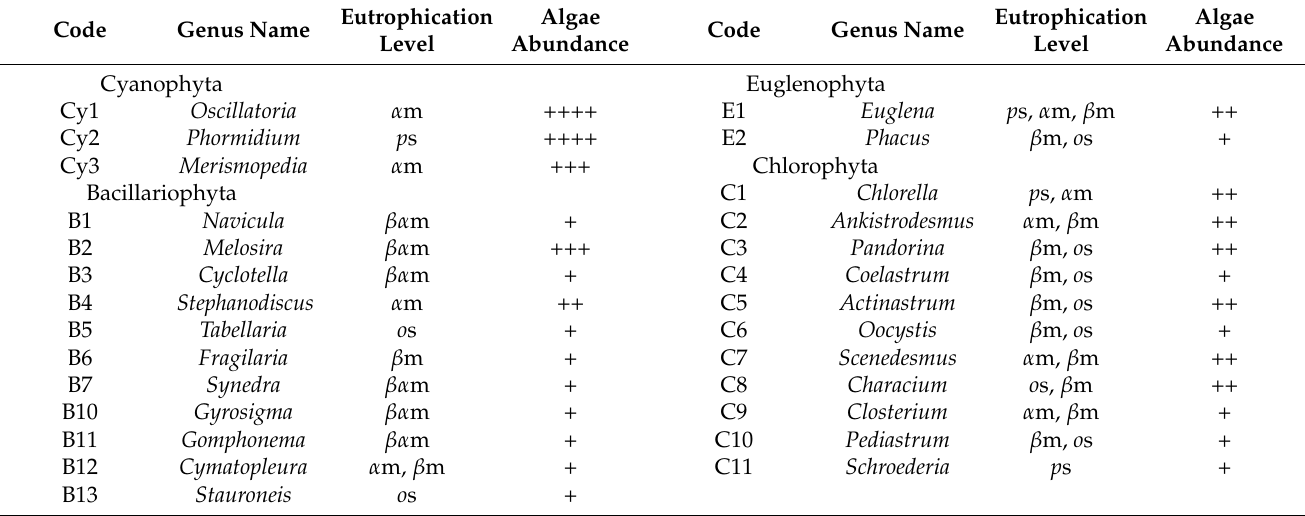
Table 1. List of algae and their indication function of eutrophication